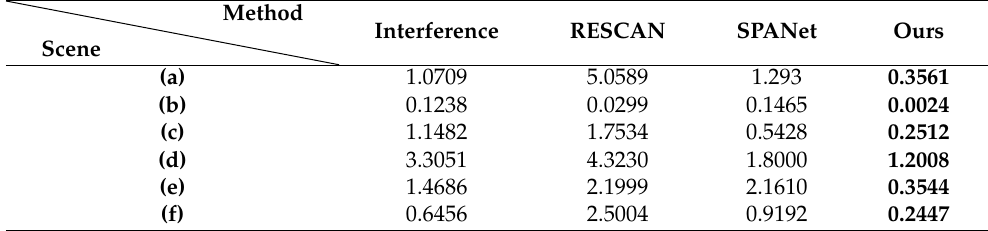
Table 3. Comparisons of ∆ ENL for measured data.